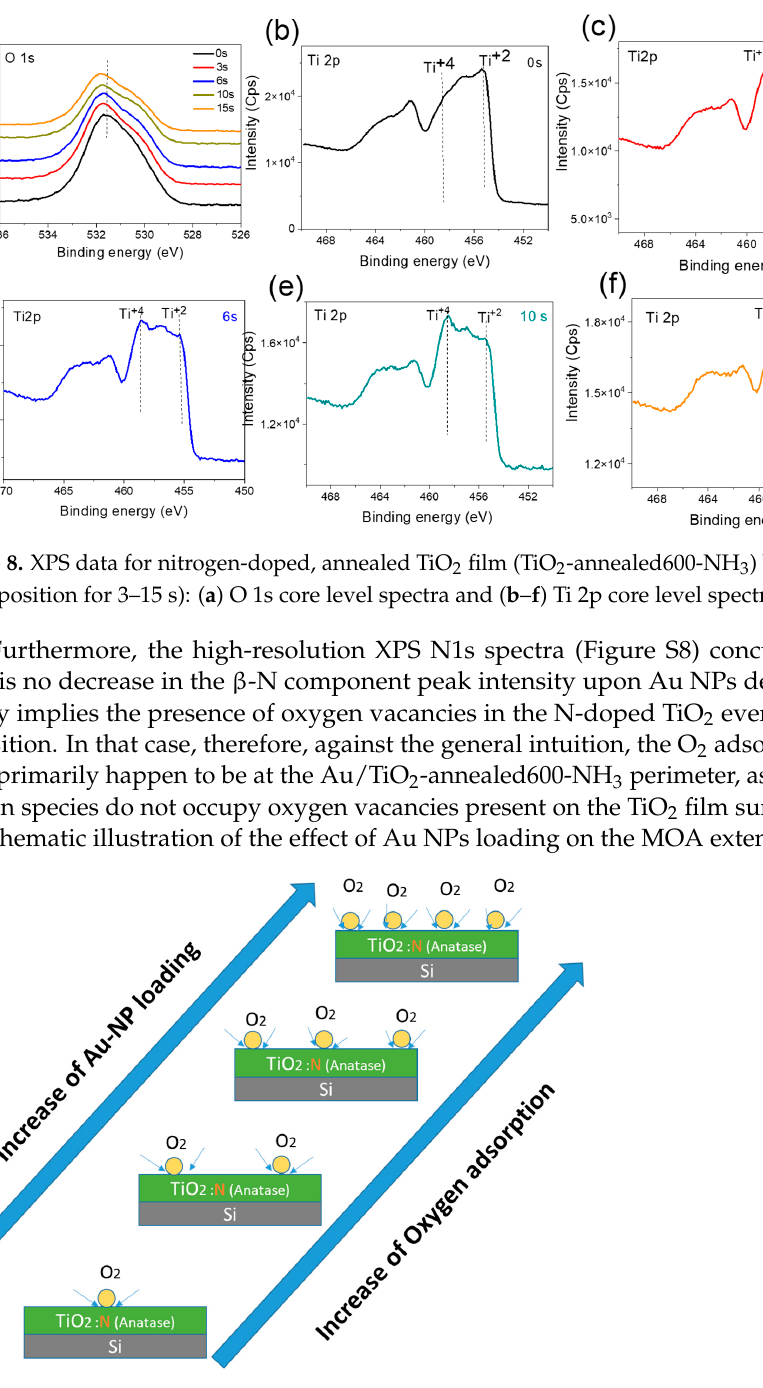
Figure 9. Schematic representation of the effect of Au NP loading on the extent of molecular oxygen attachment to the nitrogen-doped anatase TiO 2 film